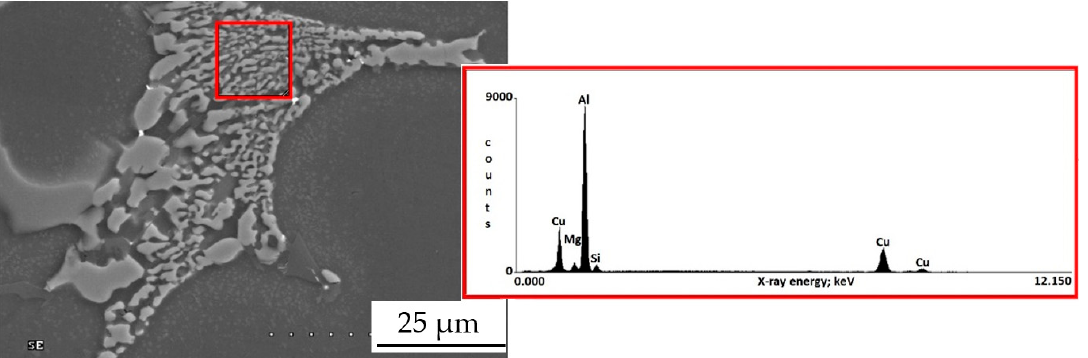
Figure 9. Region of the quaternary eutectic in the alloy with ~0.2 wt % V and W from the shell sand probe and the distribution analysis of elements.